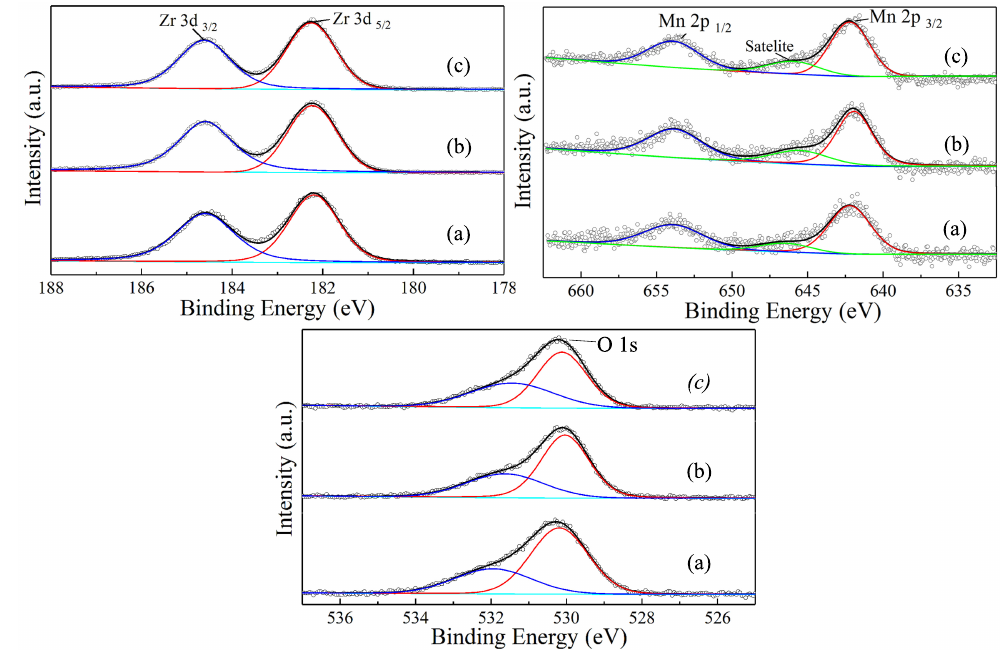
Figure 3. XPS high resolution spectrum of Zr 3d, Mn 2p and O 1s for Zr 1 − x Mn x O 2 − δ ( a ) x = 0.15, ( b ) x = 0.2, ( c ) x =